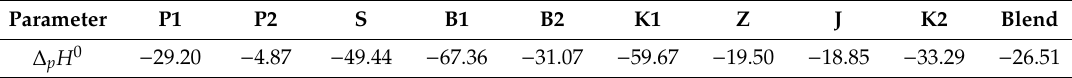
Table 8. Average chemical enthalpy of pyrolysis reaction, kJ/kg.